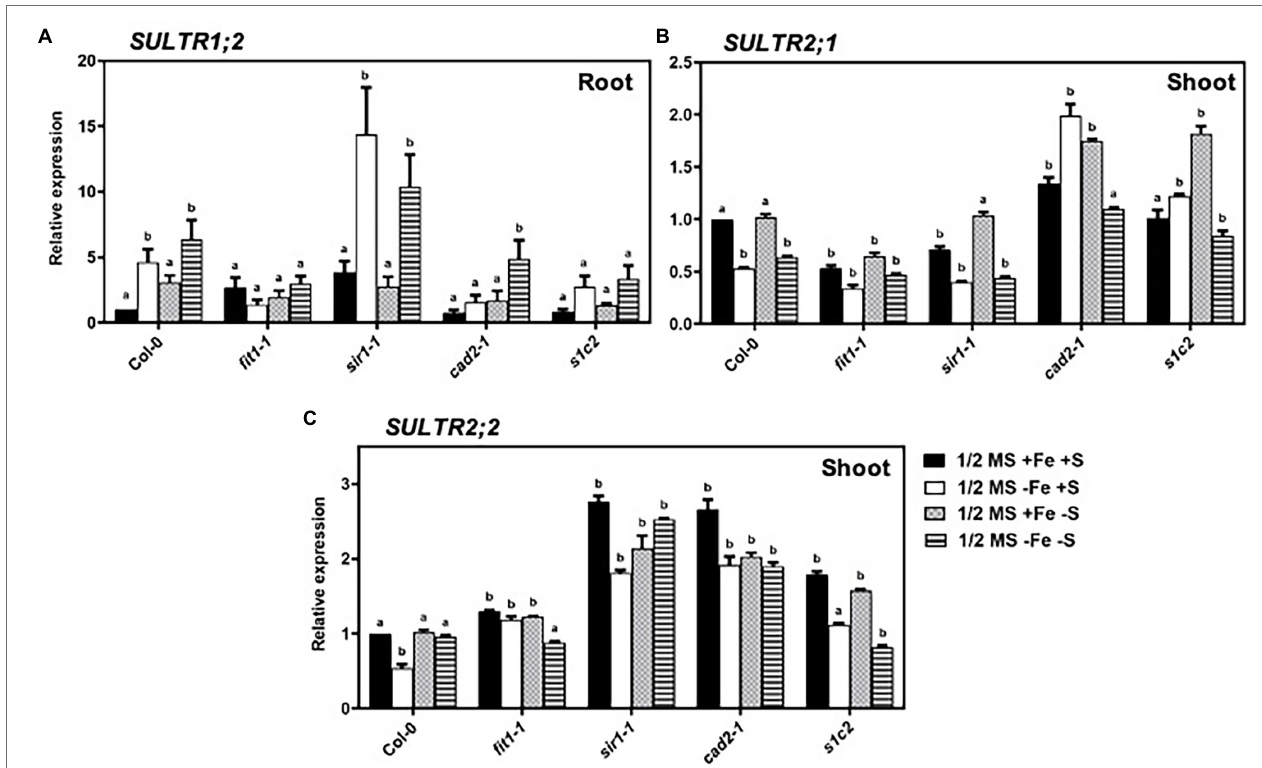
FIGURE 3 | Expression profiles of sulfate transporter genes in Arabidopsis . Relative expression by Quantitative RT-PCR of the genes: (A) SULTR1;2 in roots, (B) SULTR2;1 in shoots, (C) SULTR2;2 for Arabidopsis wild type (Col-0), fit1-2 , sir1-1 , cad2-1 , and s1c2 lines of 1-week old seedlings exposed to half-strength MS medium (1/2 MS + Fe + S), Fe-deficient (1/2 MS − Fe + S), S-deficient (1/2 MS + Fe − S), and Fe and S-deficient (1/2 MS − Fe − S) media for 4 days under long-day conditions. The y -axis shows RNA levels normalized to that of GADPH . (A–C) Letters indicate the statistically significant differences between the wild type (Col-0) on ½ MS + Fe + S with the other treatments in Col-0 and mutants determined with the two-way ANOVA test followed by Dunnett’s test ( p < 0.05, n = 3). Bars represent means ±